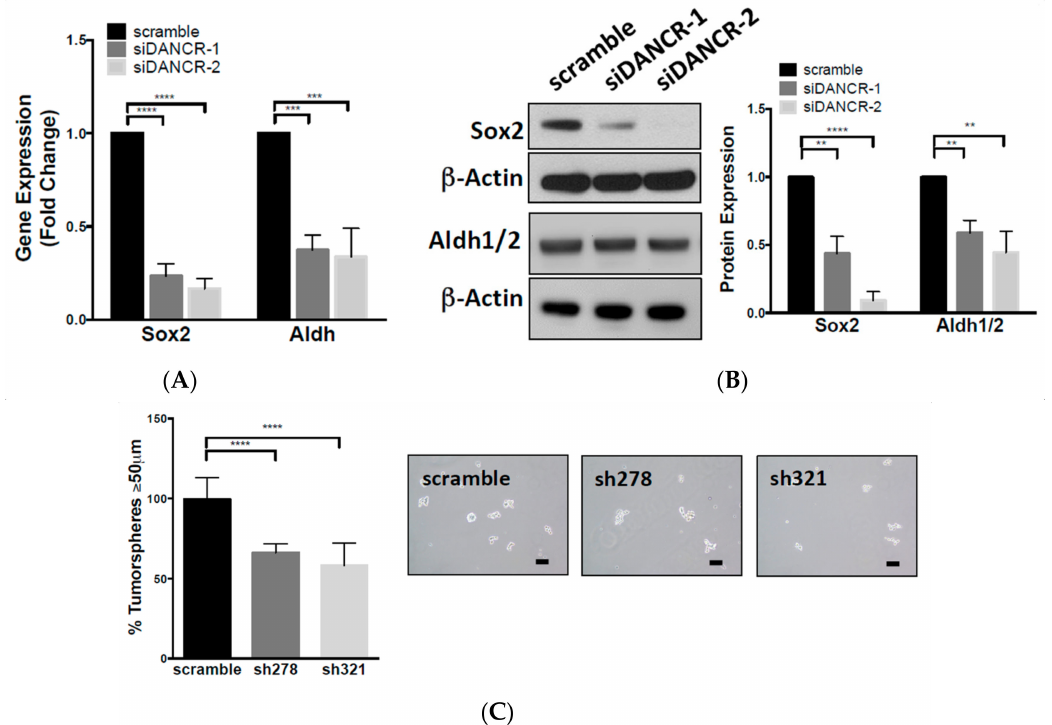
Figure 3. Knockdown of lncRNA-DANCR expression in NSCLC cells inhibits stem-cell characteristics. ( A ) Fold change of SOX2 and ALDH gene expression in A549 DANCR KD cells compared to scramble control ( n = 3, t test, *** p < 0.001), n = 3; t test, **** p < 0.0001); ( B ) fold change of Sox2 and Aldh1 / 2 protein expression in A549 DANCR KD cells compared to scramble control ( n = 3; t test, ** p < 0.01, **** p < 0.0001); ( C ) tumorsphere formation in stable A549 DANCR KD cells compared to scramble control. Representative images of tumorspheres shown, scale bar = 100 γ m ( n = 3, t test, **** p <